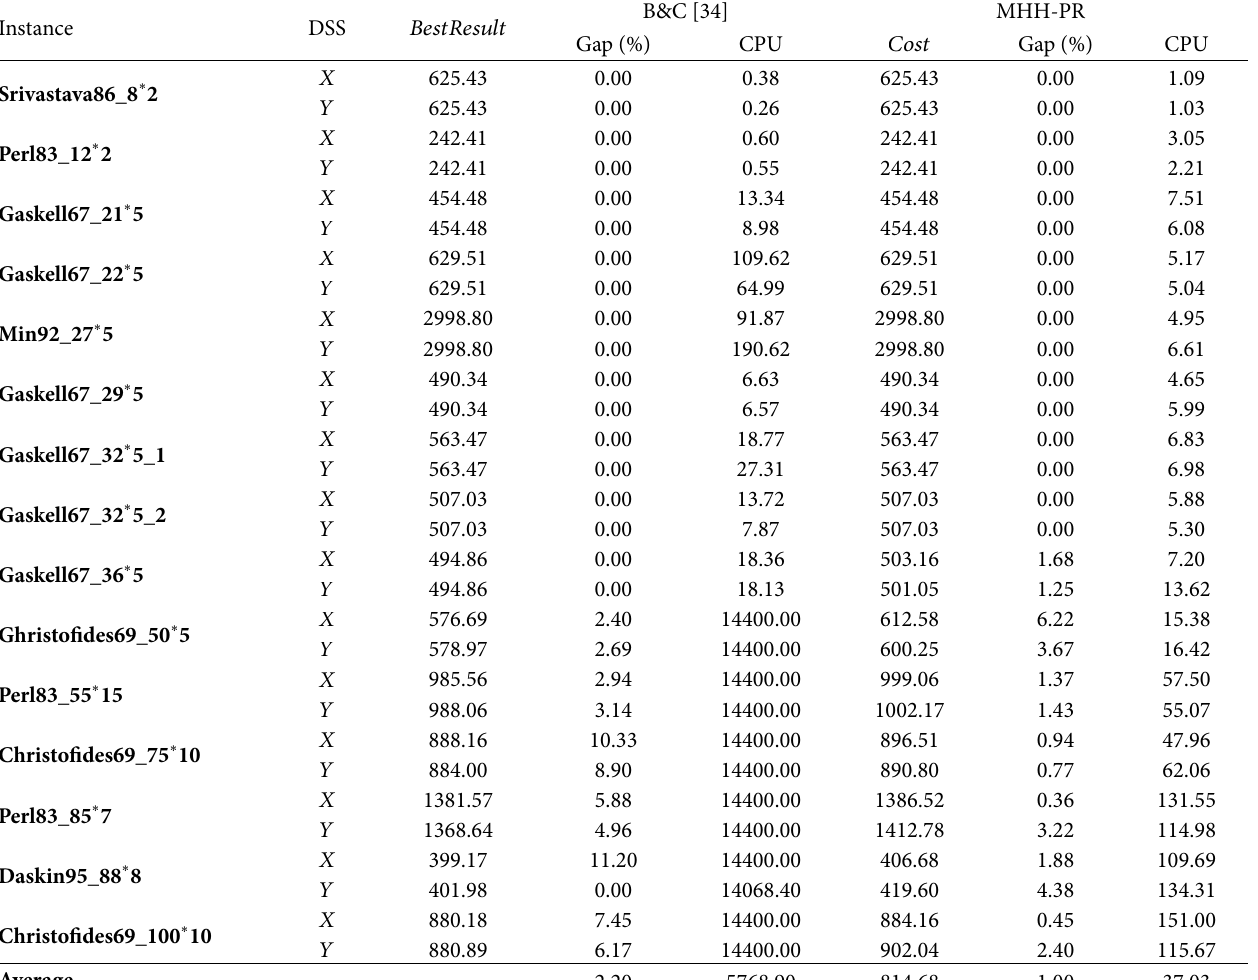
Table 4: Comparison of proposed heuristic and B&C on Barreto’s LRPSPD instances.